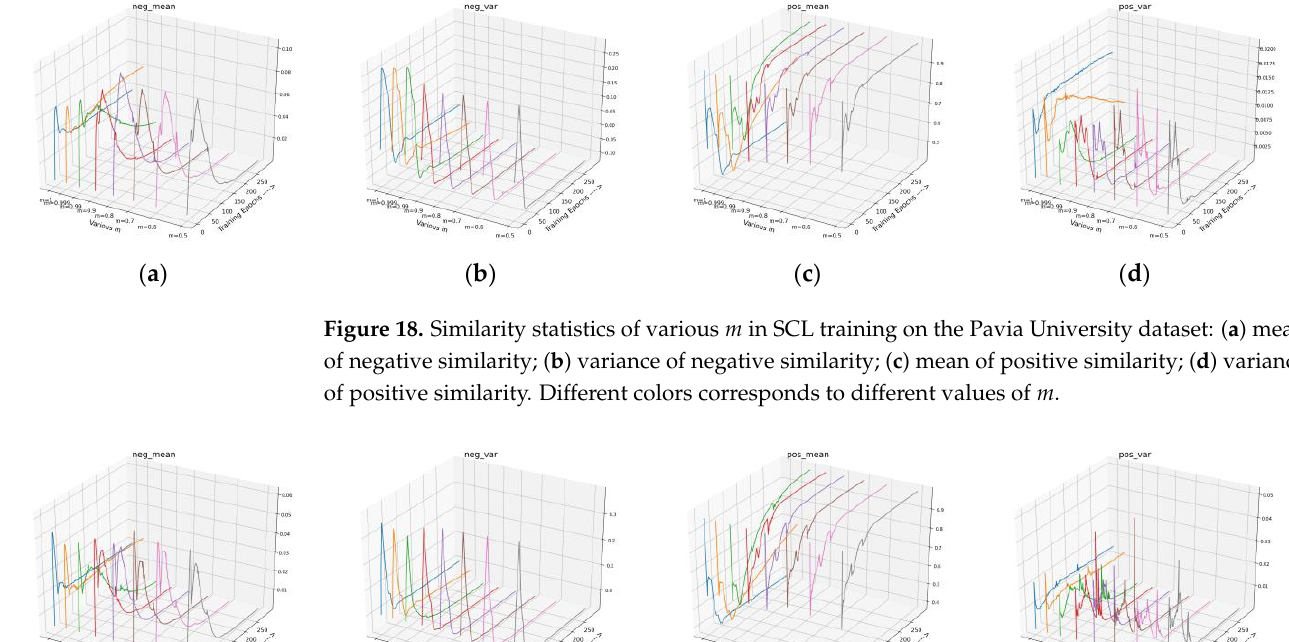
negative similarity; ( b ) variance of negative similarity; ( c ) mean of positive similarity; ( d ) variance